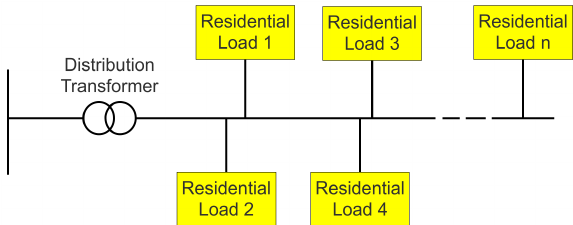
Figure 2. Schematic of the employed distribution network.